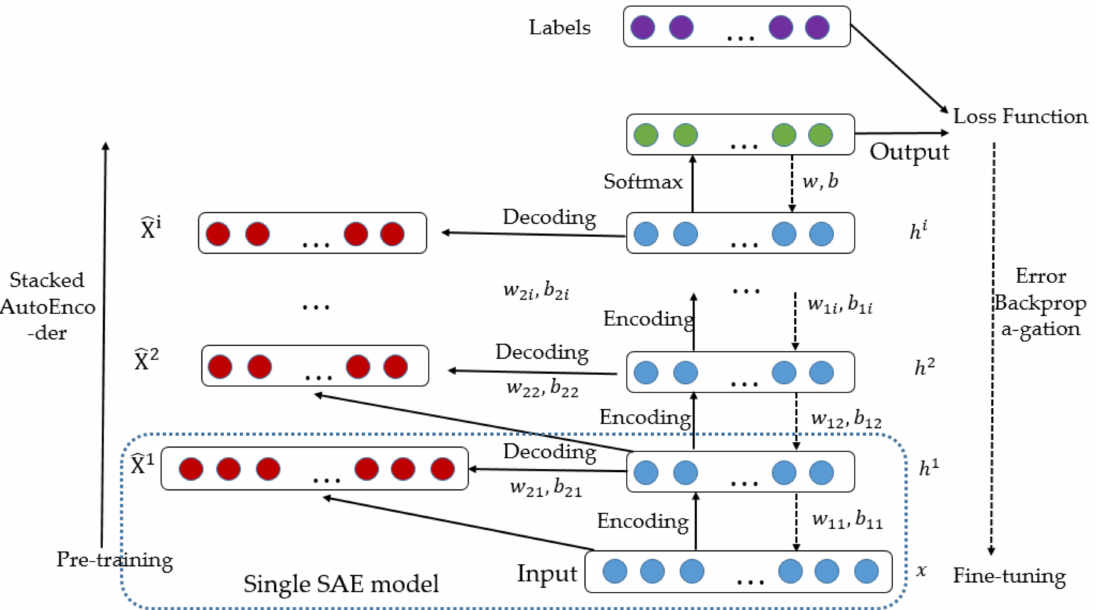
Figure 3. SAES-DNN network model structure. The model consists of SAEs and a DNN. The DNN adjusts the weight parameters of the model through feedback training, and the SAEs reduce the dimension of feature dimension through